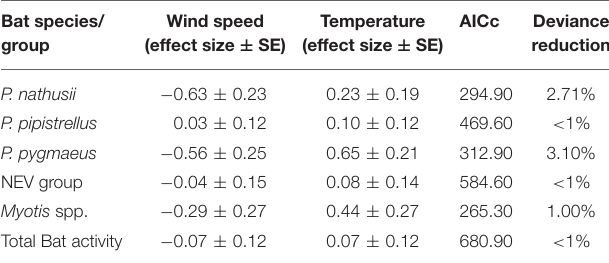
TABLE 3 | Effect sizes ( ± SE) for wind speed and temperature derived from GLMMs with a negative binomial distribution. Bat species/